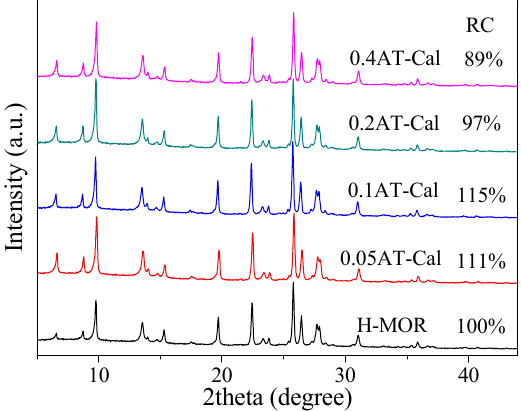
Figure 3. XRD patterns of the samples before and after alkali treatment.